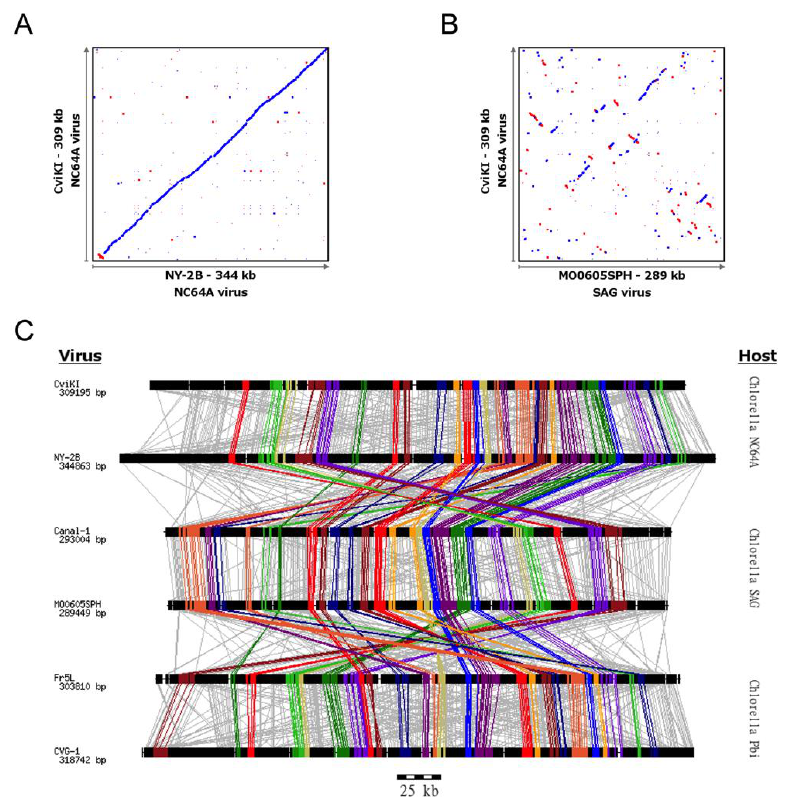
Figure 1. Gene dot plots and gene alignments across chlorovirus host types. Dot-plot alignments of two Chlorovirus genomes infecting the same ( A ) or different ( B ) host (blue indicates common genomic orientation, red indicates opposite genomic orientation). Each dot represents a protein match between the two viruses (BLASTp expect value < 1 × 10 − 5 ). ( C ) Schematic representation of six Chlorovirus genomes from three different hosts. Each genome is depicted as a black line with genic regions represented by black boxes. Lines are connecting genes from the same family of homologous proteins (for clarity purpose, the six bigger families were removed). The colored set of genes and lines represents the 25 gene gangs. While viruses that infect the same host often demonstrate good conservation of synteny ( A ), synteny is poorly conserved across virus types ( B ). Despite generally poor syntenic conservation, gene-centric alignments suggest the existence of some conserved collinear blocks ( C ).